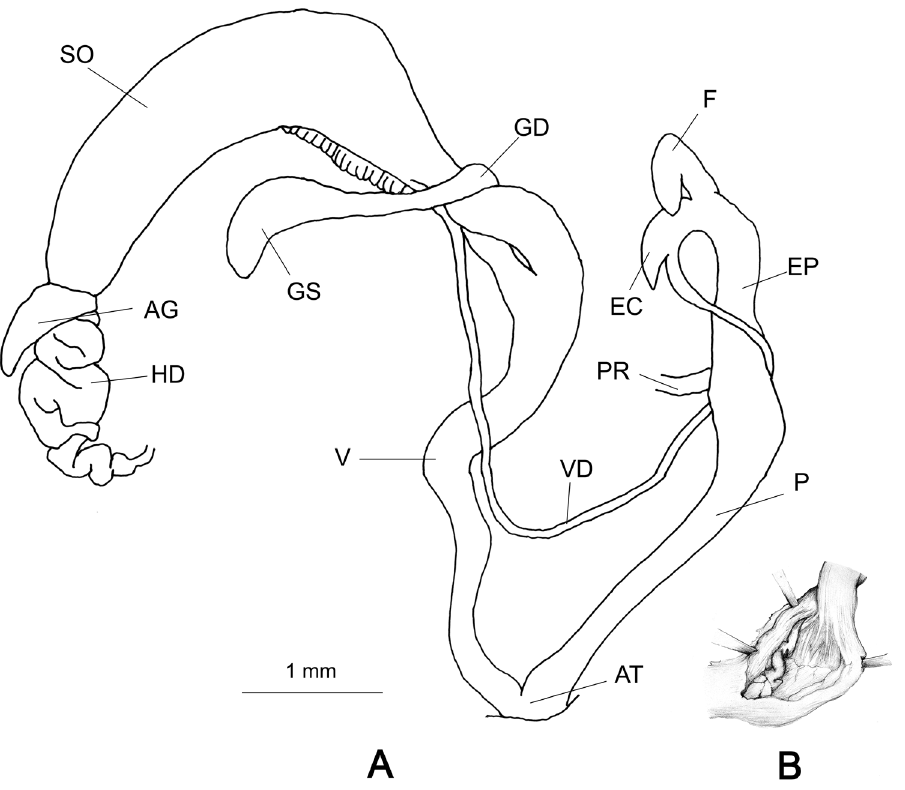
Figure 10. Genitalia of R. rishikeshi sp. n., holotype: CDZMTU0170P, A General view B Interior of penis of the same, Jhawalepakho Community Forest, Ridi, Gulmi District, montane hill Shorea robusta forest.